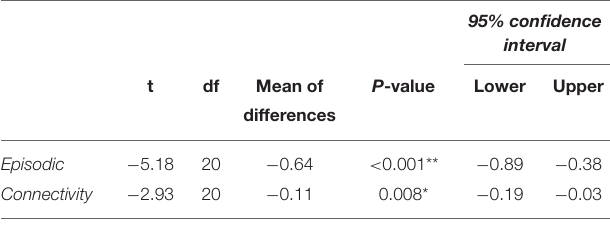
TABLE 2 | Difference between TLE and controls on episodic memory, and between left and right parietofrontal connectivity in patients with